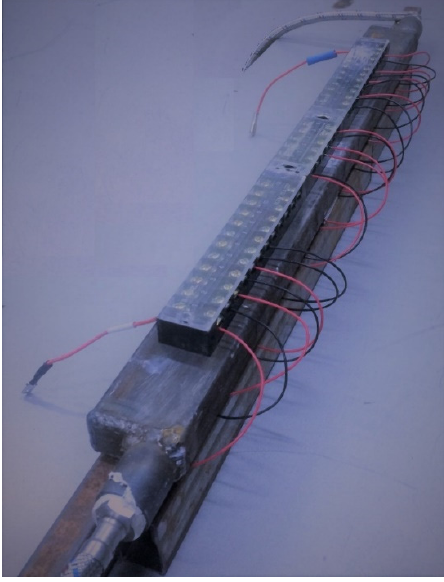
Figure 17. Unit of the thermoelectric converter of the gas cooling module.